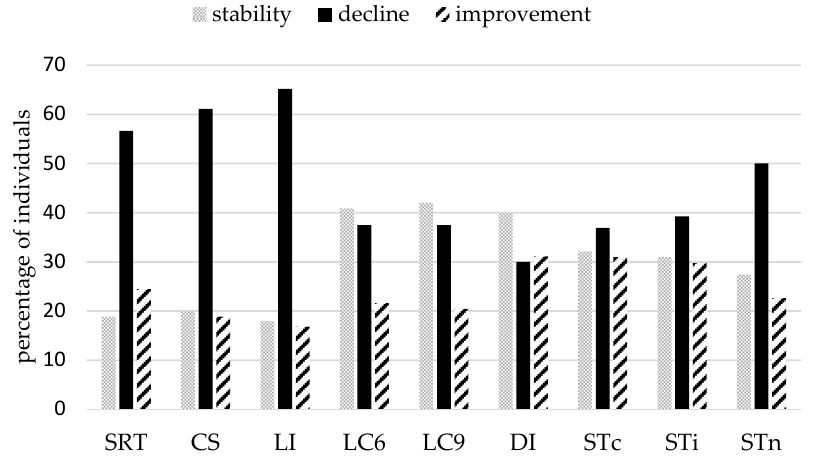
Figure 3. Bootstrap analyses: Percentage of individuals by task/condition and by pattern of change. Bars represent the percentage of individuals showing significant decline over seven years (black bars), significant improvement (dashed bars) and no significant change (grey